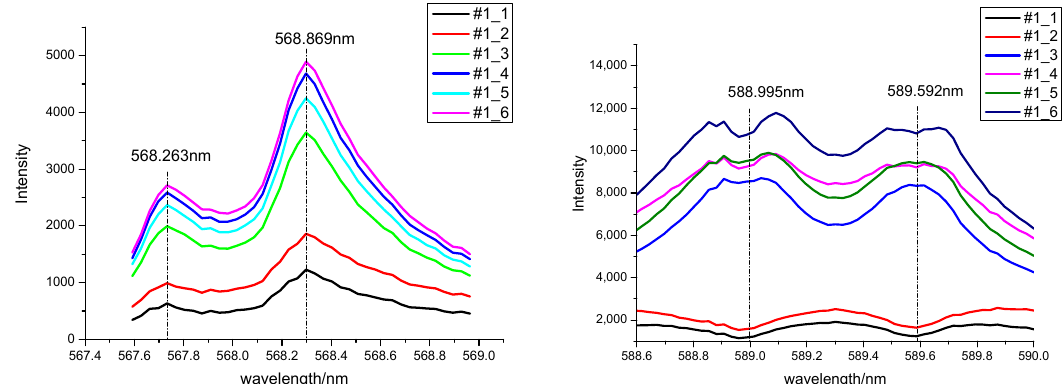
Figure 3. Emission intensity of Na in samples #1-1 through #1-6 measured at different wavelengths at an energy intensity of 3.8 J/cm 2 . Spectra show the resonance lines (588.995 nm, 589.592 nm) and nonresonant lines (568.263 nm, 568.859 nm).